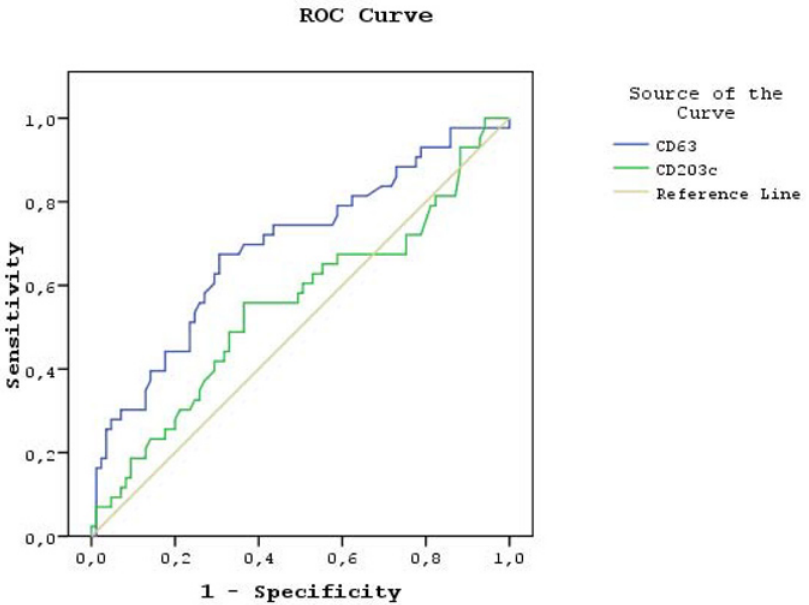
Figure 5. CD63 and CD203c ROC curves.